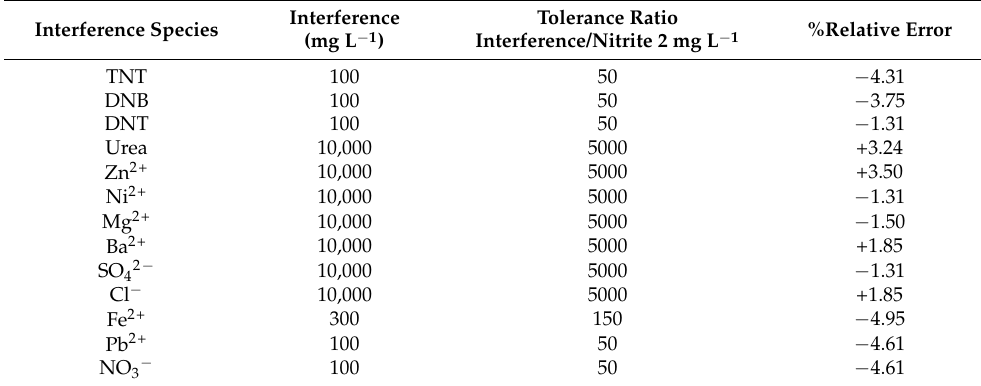
Table 2. Tolerance ratio of interferences on the determination of 2 mg L − 1 nitrite.